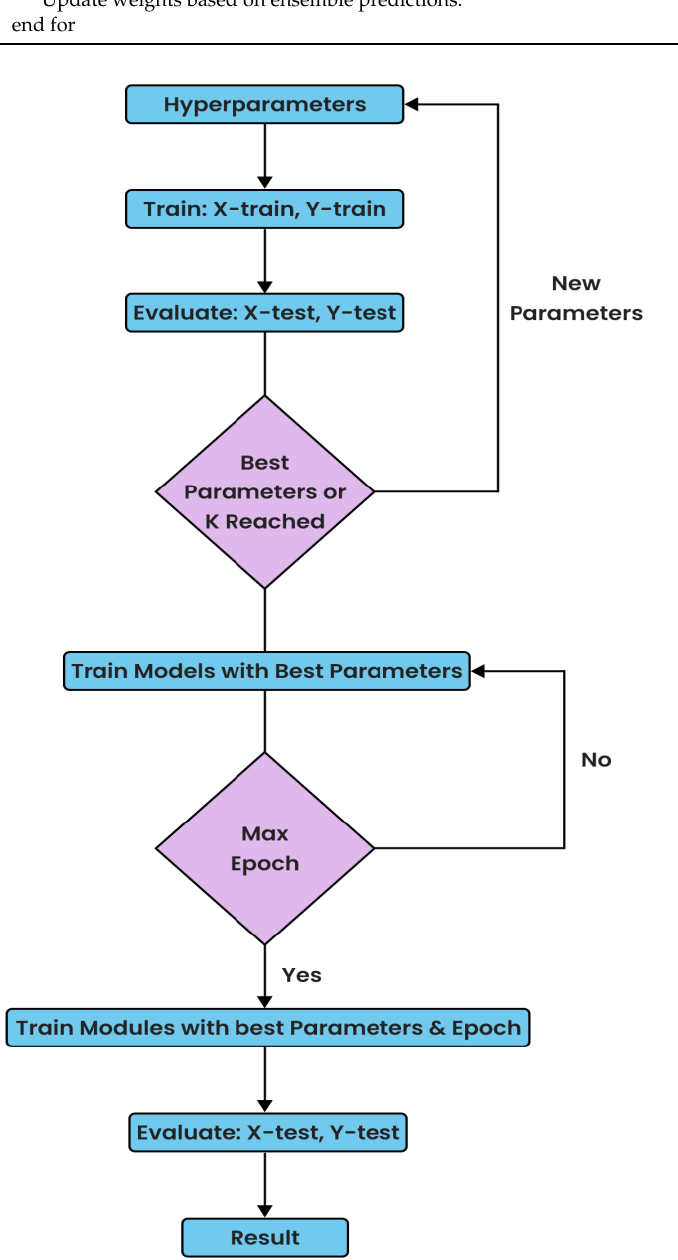
Figure 5. Hyperparameter Tuning.